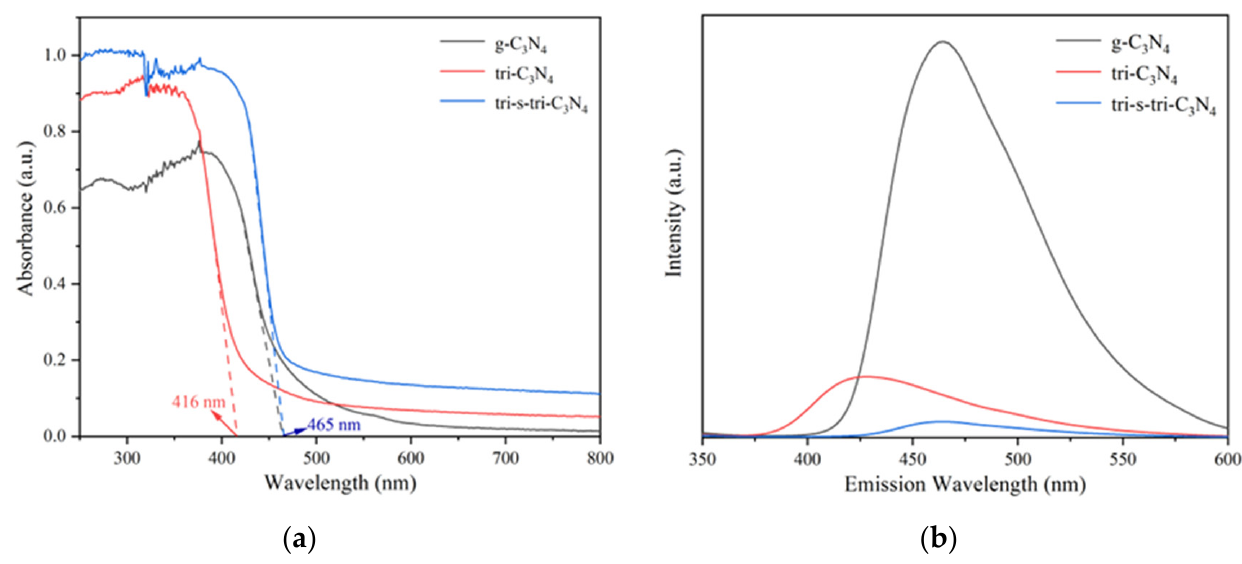
Figure 5. UV-vis/DRS spectra ( a ) and PL spectra ( b ) of g-C 3 N 4 , tri-C 3 N 4 , and tri-s-tri-C 3 N 4 .